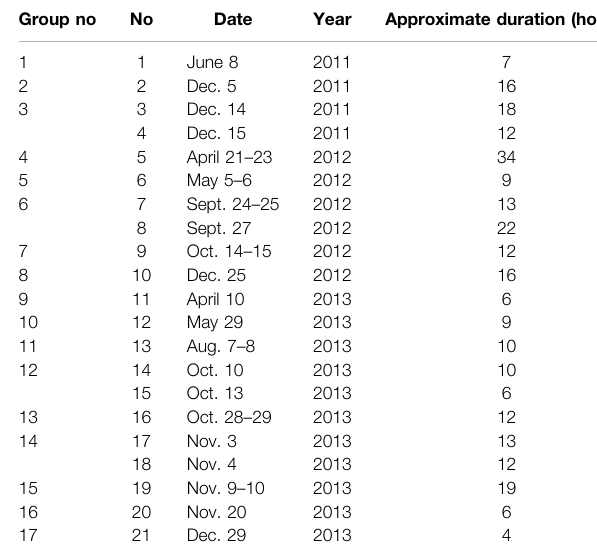
TABLE 1 | Cloud anomalies in Italy and their duration in 2010 –